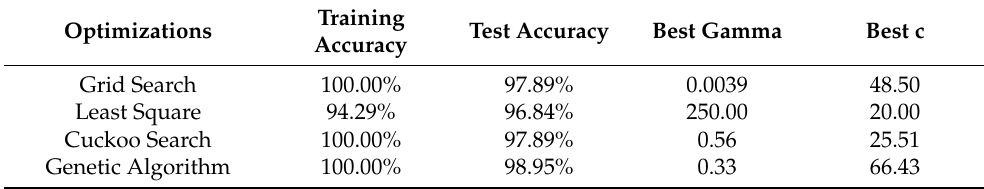
Table 3. Classification accuracy of training sets and test sets from SVM